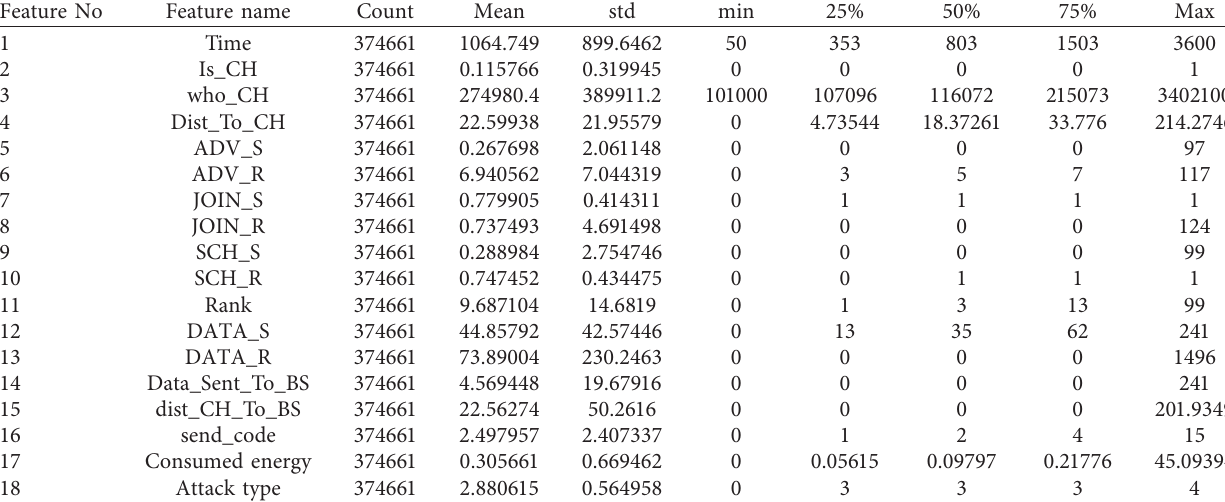
Table 2: Statistical analysis of WSN-DS dataset.